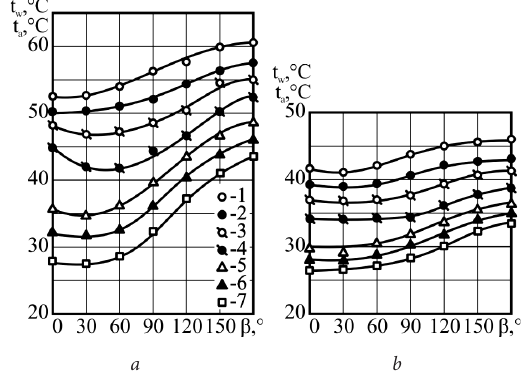
Fig. 2. Dependence of the temperature of the fin wall and air in the interfin channel on the angle of attack β and the height of the location of thermocouples on the fin: a – Re d =10042; b – Re d =28,647; 1 – h f,i =0,0 mm;